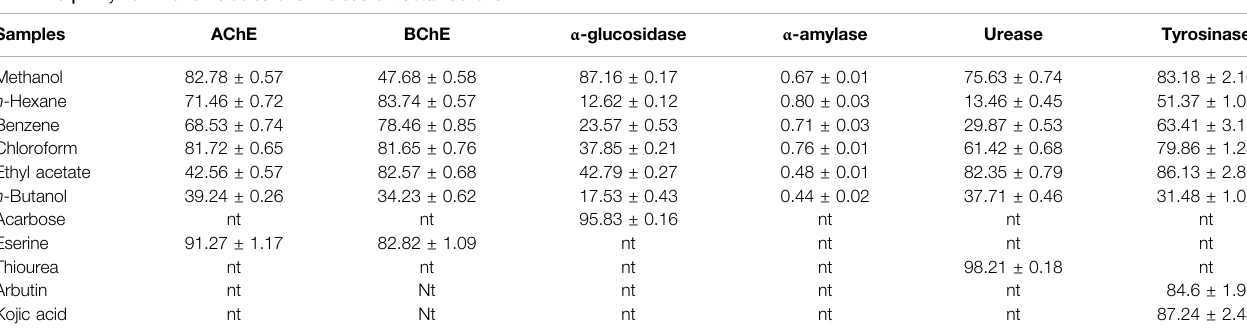
TABLE 6 | Enzyme inhibition studies of S. indicus extracts/fractions.